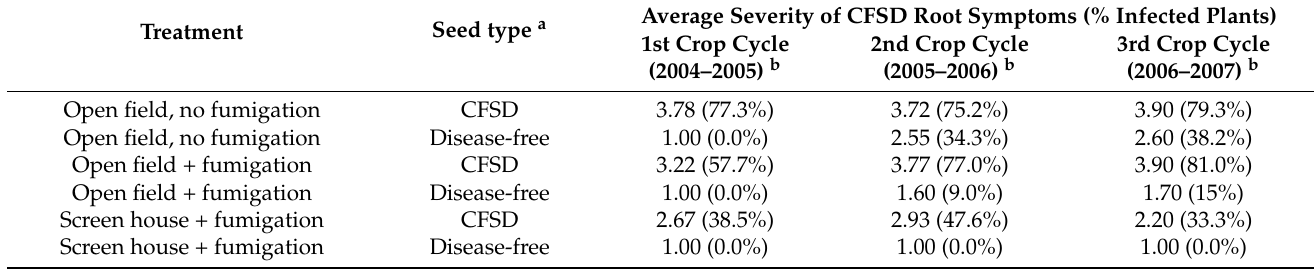
Table 1. Three-year evaluation of CFSD root symptoms’ development under different conditions. Stakes from CFSD-affected plants came from the municipality of Jamundi, Valle del Cauca, and the disease-free stakes from the municipality of Montenegro, Quind í o, where CFSD had not been reported before. Field trials were carried out in Santander de Quilichao (Department of Cauca, Colombia), under a high CFSD pressure. Fumigations were performed every 15 days using a mix of Malathion 1 mL/L, Thiamethoxam: 0.5 g/L, and Lambda-cyhalothrin: 2 mL/L. Each treatment used three repetitions of twelve plants each and a split plot experimental design. To record symptoms’ development per plant, one stake per plant was used for the next season. All stakes were treated with insecticide prior to planting (immersion in 2 mL/L of 0, 0-diethyl-S-methyl carbamoyl methyl